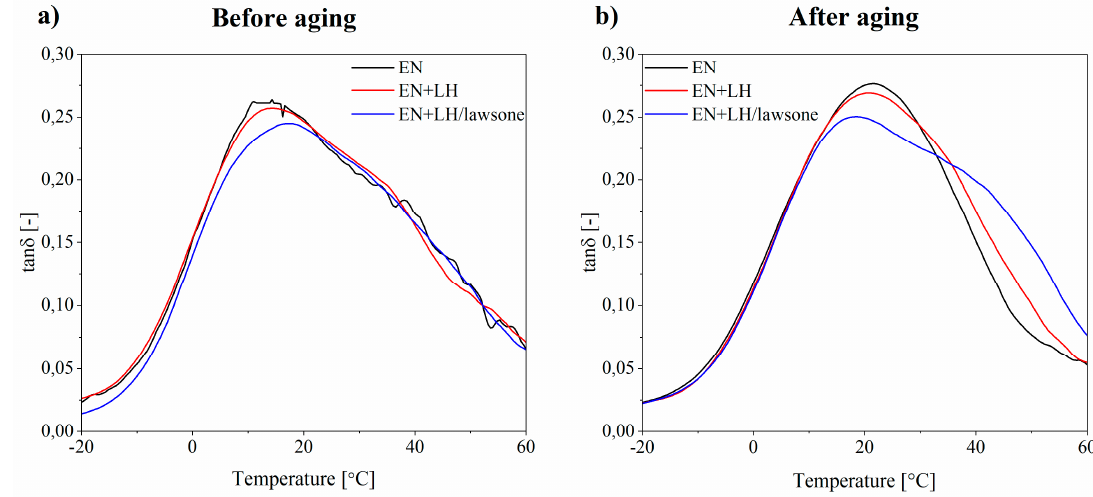
Figure 10. Temperature dependence of tan δ at 5 Hz for EN, EN + LH and EN + LH / lawsone composites before ( a ) and after ( b ) 350 h of aging.